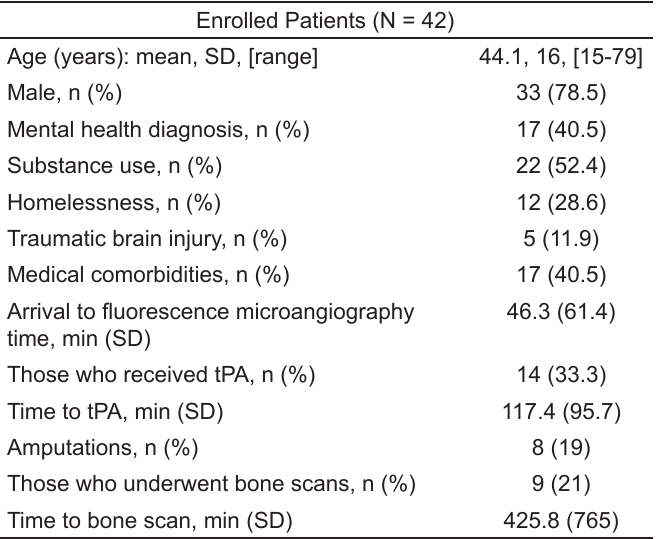
Table 1. Demographics of enrolled patients, time characteristics of diagnostic testing, and therapies.